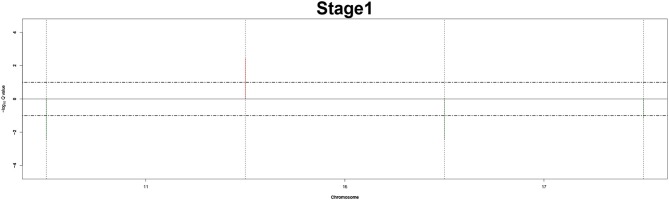
Recurrent genome-wide SCNAs in stage 1. Genome-wide amplifications (red blocks) and deletions (green blocks) in stage 1.